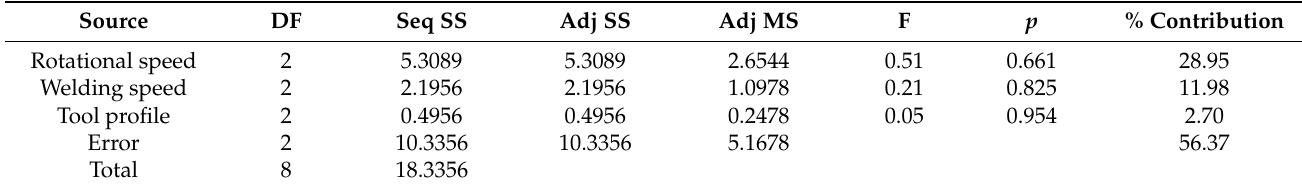
Table 10. Analysis of variance for hardness means.